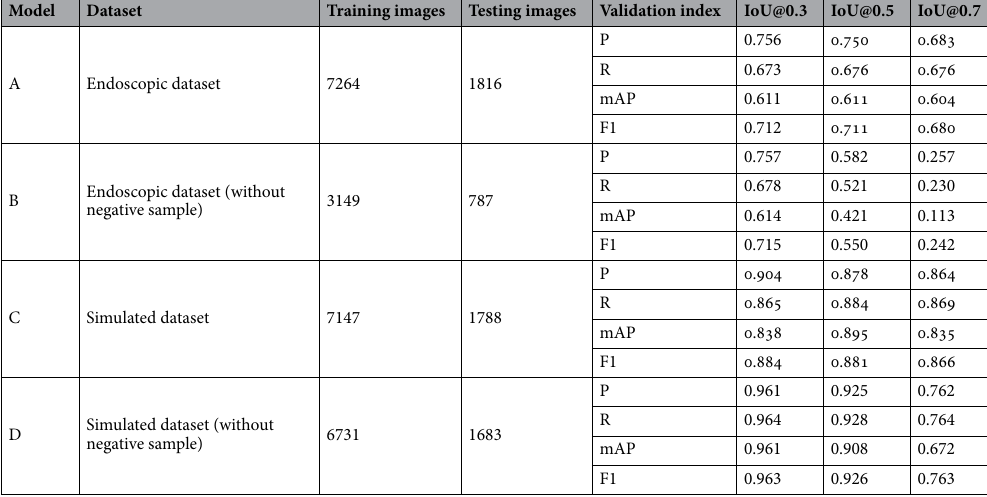
Table 1. Results of the recall, precision, mAP, and F1 score in the lumen detection experiments for 4 models with images from endoscopic and simulated